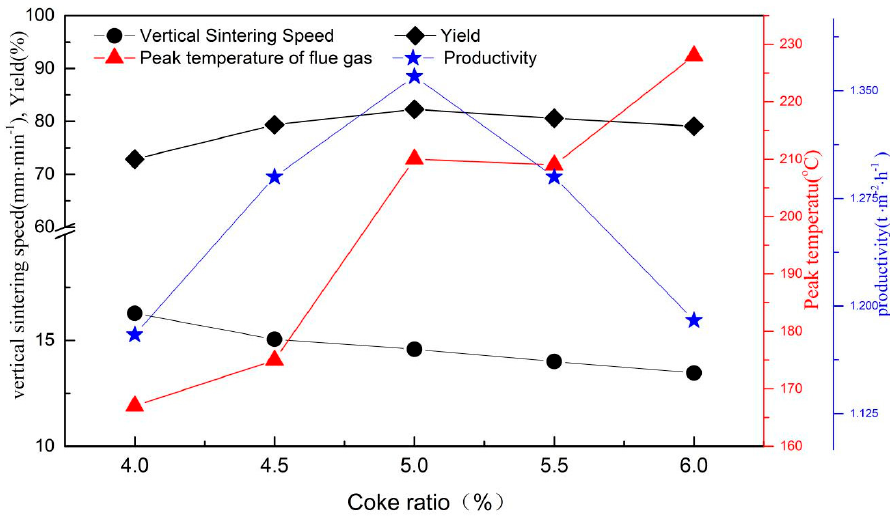
Figure 3. Effect of the coke ratio on the HCVTS sintering process.